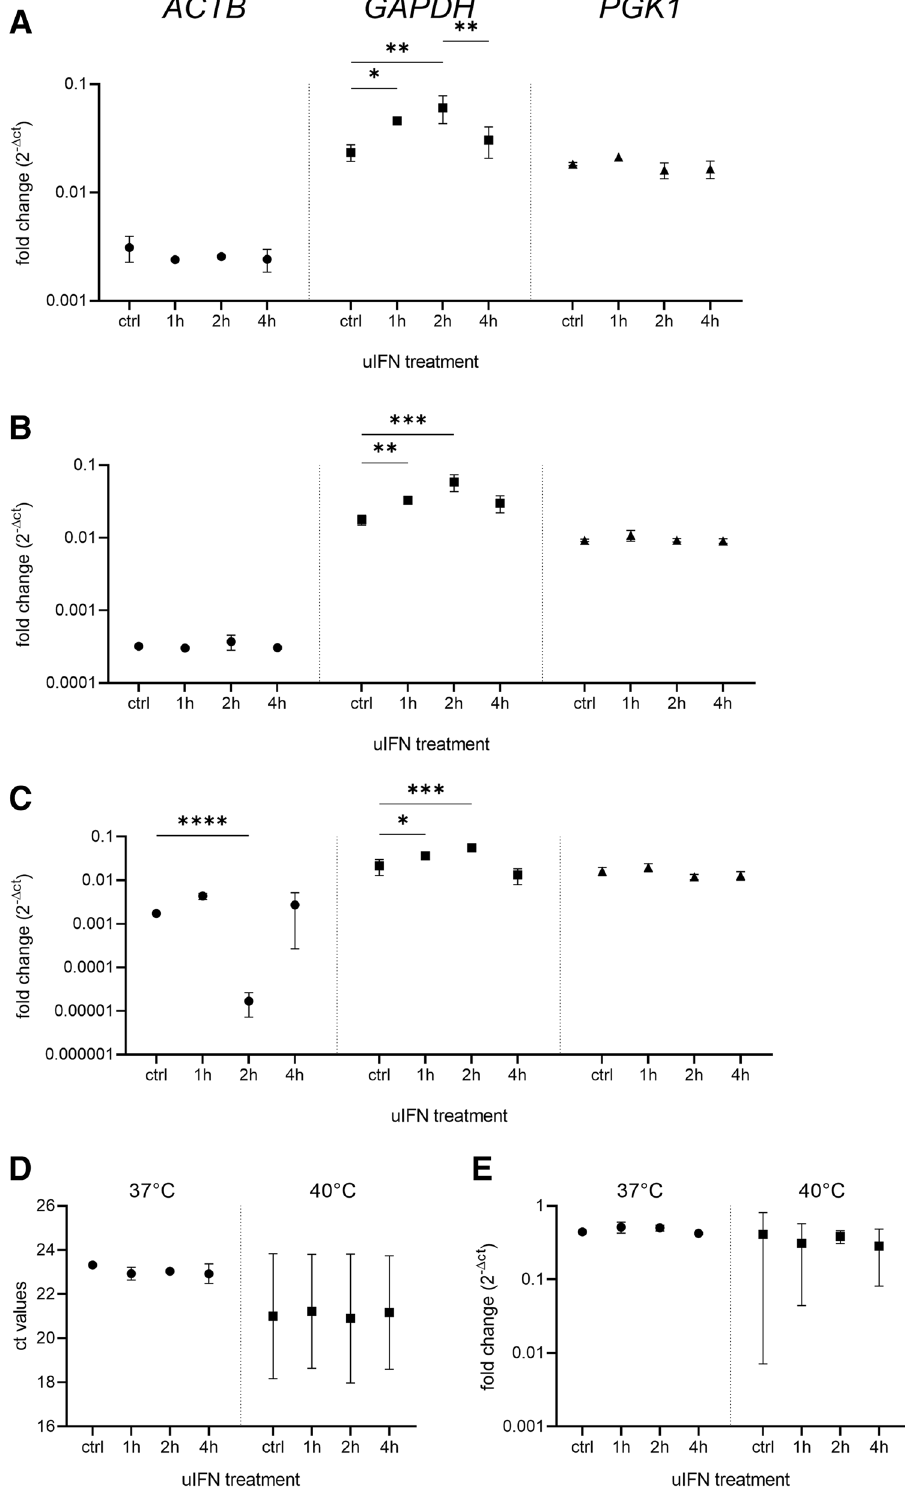
Figure 3. GAPDH expression is induced by IFN-I in R. aegyptiacus . Relative gene expression of ACTB , GAPDH and PGK1 normalized to EEF1A1 upon uIFN treatment at 35 °C ( A ), 37 °C ( B ) or 40 °C ( C ). ( D, E ) Ct values of human ACTB and GAPDH ( D ) and relative expression of human GAPDH normalized to ACTB ( E ) in human fibroblasts upon uIFN treatment and incubation at 37 °C or 40 °C. Bat ( A, B, C ) or human ( D, E ) primary fibroblasts were stimulated with PBS (ctrl) or 1000U/ ml universal type I interferon (uIFN) for indicated time at 35 °C, 37 °C or 40 °C. Gene expression levels of ACTB , GAPDH and PGK1 were determined with qRT-PCR. Data show mean ± SD from 3 independent experiments. The statistical significance was calculated using one-way ANOVA with Holm-Šidák’s post-hoc test. (*) P ≤ 0.05, (**) P ≤ 0.01, (***) P ≤ 0.001, (****) P ≤